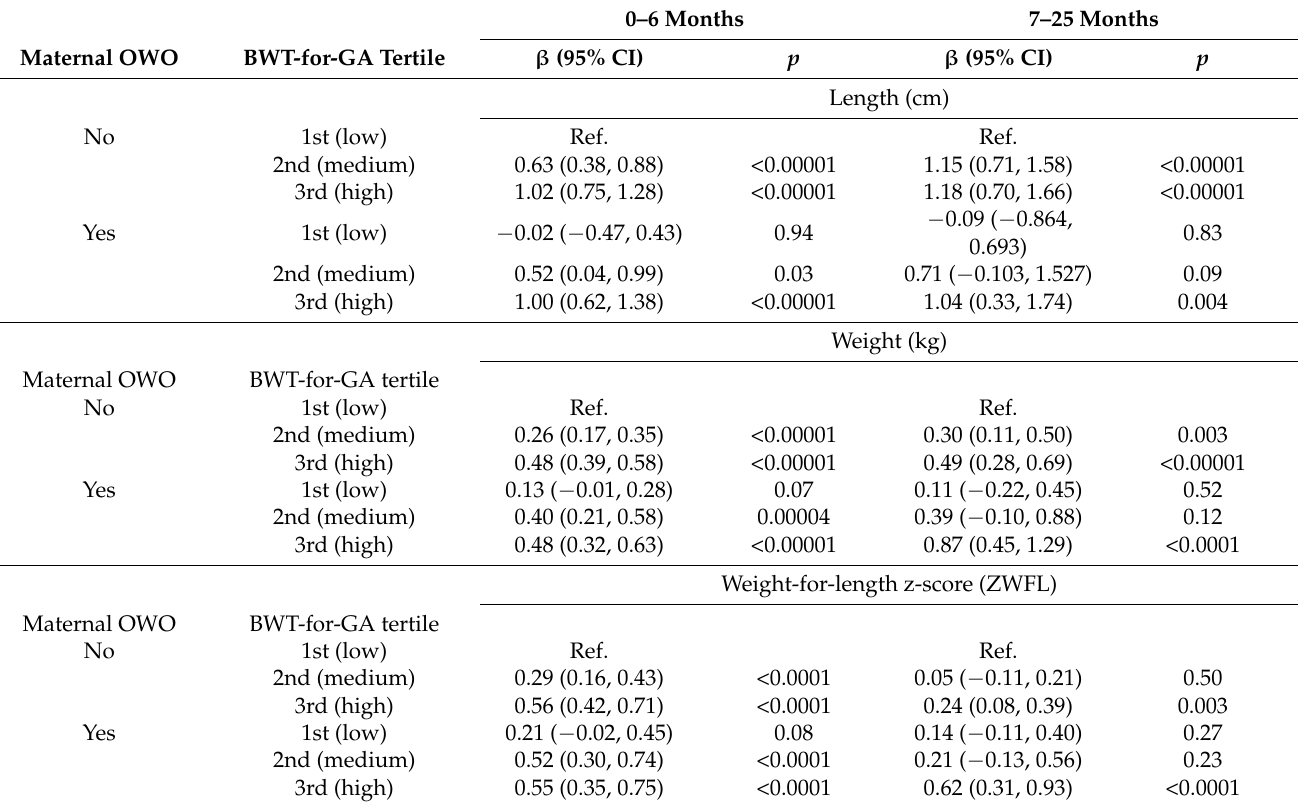
Table 2. Longitudinal data analysis of the associations of gestational age-specific tertiles of birth- weight and maternal prepregnancy overweight or obesity (OWO) with child anthropometric measures in 674 term-born AGA children from birth to age 6 months ( n = 2731 measures), and from age 7 to ~25 months ( n = 2579